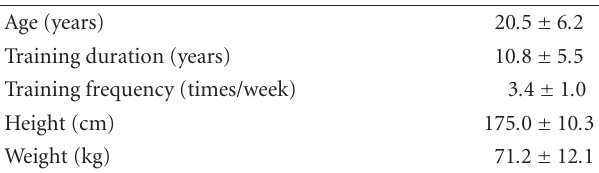
Table 1: Physical data of all soccer players examined (mean values ±